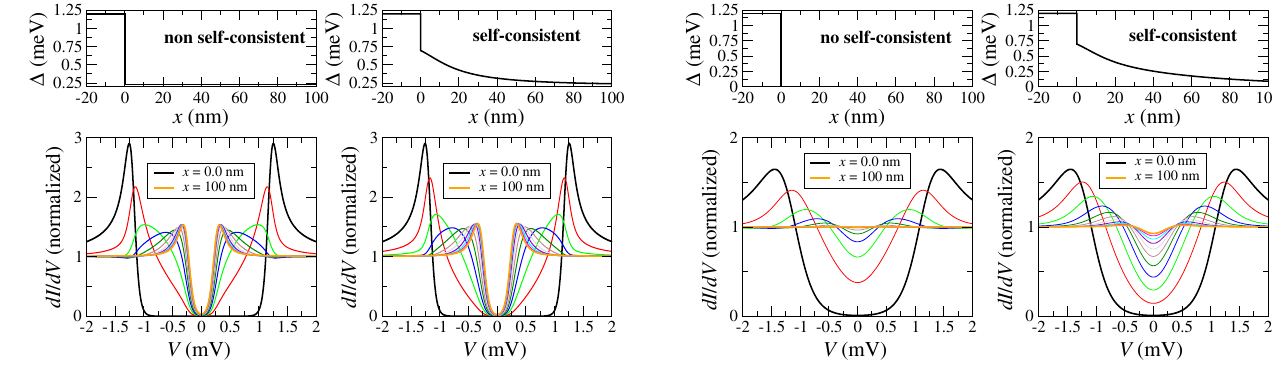
FIG. 7. The lower panels show the computed normalized dI=dV as a function of the bias voltage for T ¼ 0 . 55 K and r ¼ 0 . 0 (perfect transparency). The different curves correspond to different positions along the monolayer, x . The curves were computed in steps of 10 nm ranging from x ¼ 0 (island edge) to x ¼ 100 nm. The lower left panel corresponds to a calculation where the order parameter in the monolayer is assumed to be constant and equal to its bulk value. The lower right panel corresponds to the case in which the order parameter has been calculated in a self-consistent manner. The upper panels show the corresponding order-parameter profiles.